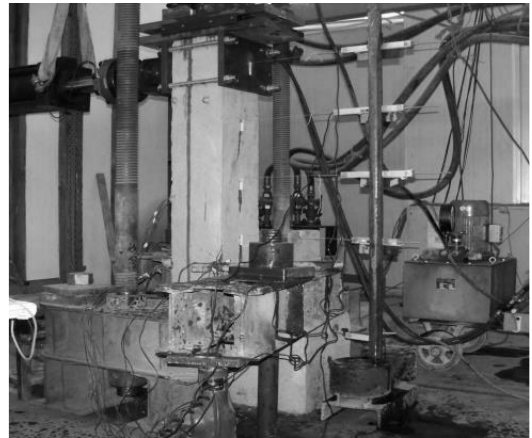
Figure 4. Scheme of test set-up.